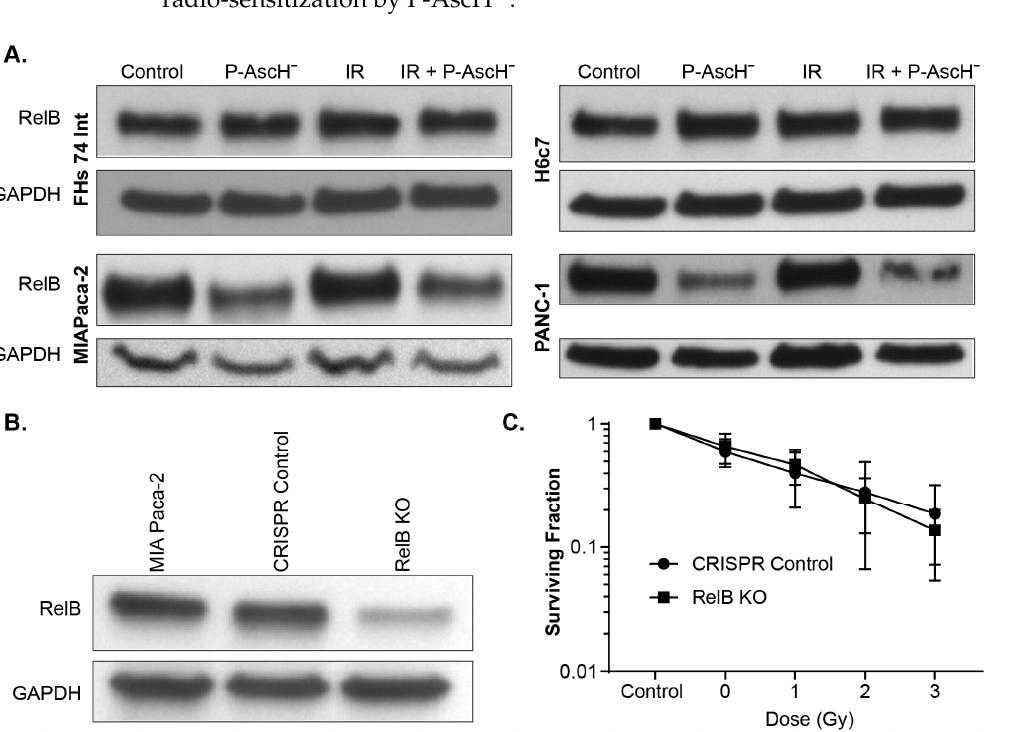
Figure 2. Role of RelB in the differential response of normal and PDAC cells. ( A ) Cells were treated with P-AscH − : MIA PaCa-2, FHs74Int, and H6c7 with 5 pmol cell − 1 (1 mM) and PANC-1 with 15 pmol cell − 1 (3 mM); radiation (5 Gy); or the combination of both. P-AscH − with or without radiation, decreases RelB levels in MIA PaCa-2 and PANC-1 cells, but not in FHs74Int and H6c7 cells; ( B ) CRISPR/Cas9 KO plasmid was used to generate RelB knockout cells in MIA PaCa-2 PDAC (RelB KO). Control cells (CRISPR control) were generated by transfecting parental cell lines with control CRISPR/Cas 9 plasmid, resulting in decreased immunoreactive protein in the RelB KO; ( C ) clonogenic survival. Treatment of PDAC CRISPR control and RelB KO with P-AscH ⁻ (5 pmol cell − 1 , 1 mM) and IR (1–3 Gy), showed no differences in clonogenic survival between the two groups.